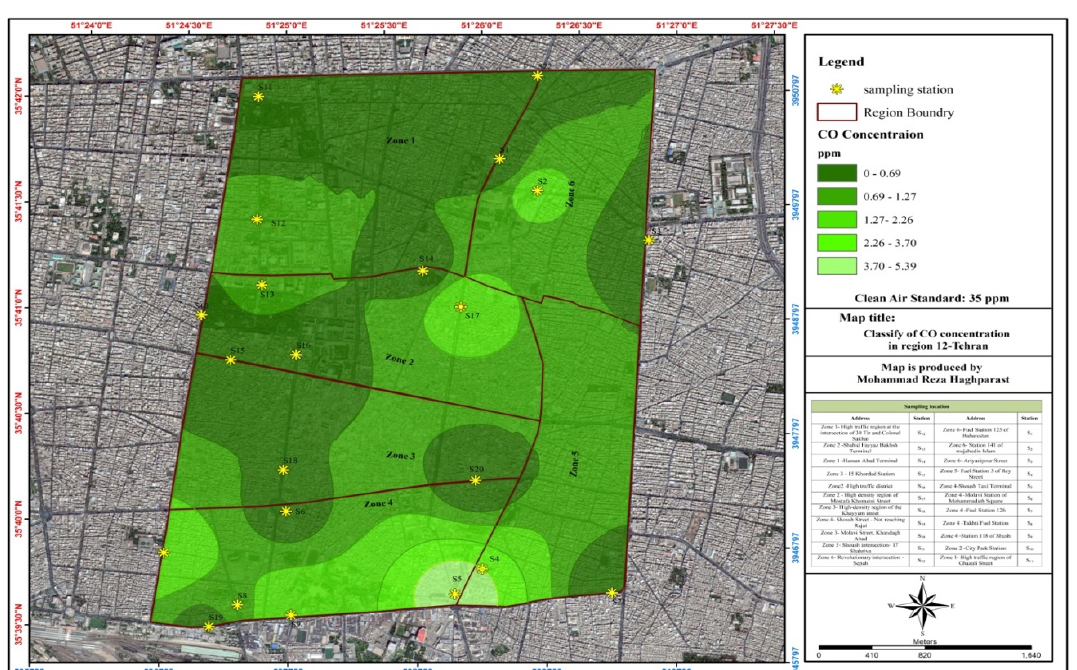
Figure 4. Zoning carbon monoxide concentration in the region on January, 2018